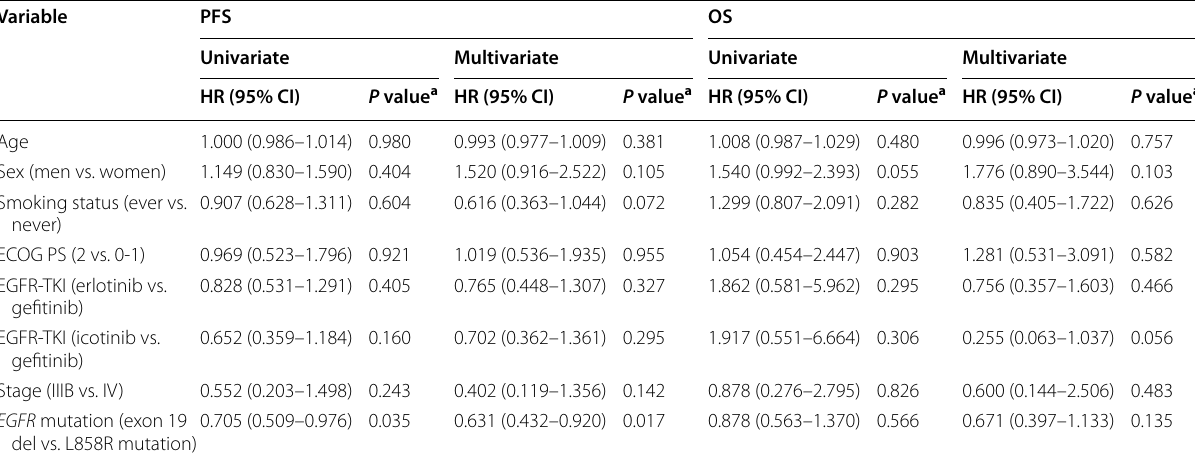
Table 3 Univariate and multivariate analyses for the PFS and OS of patients with tissue detected mutation and the use of TKIs as first-line